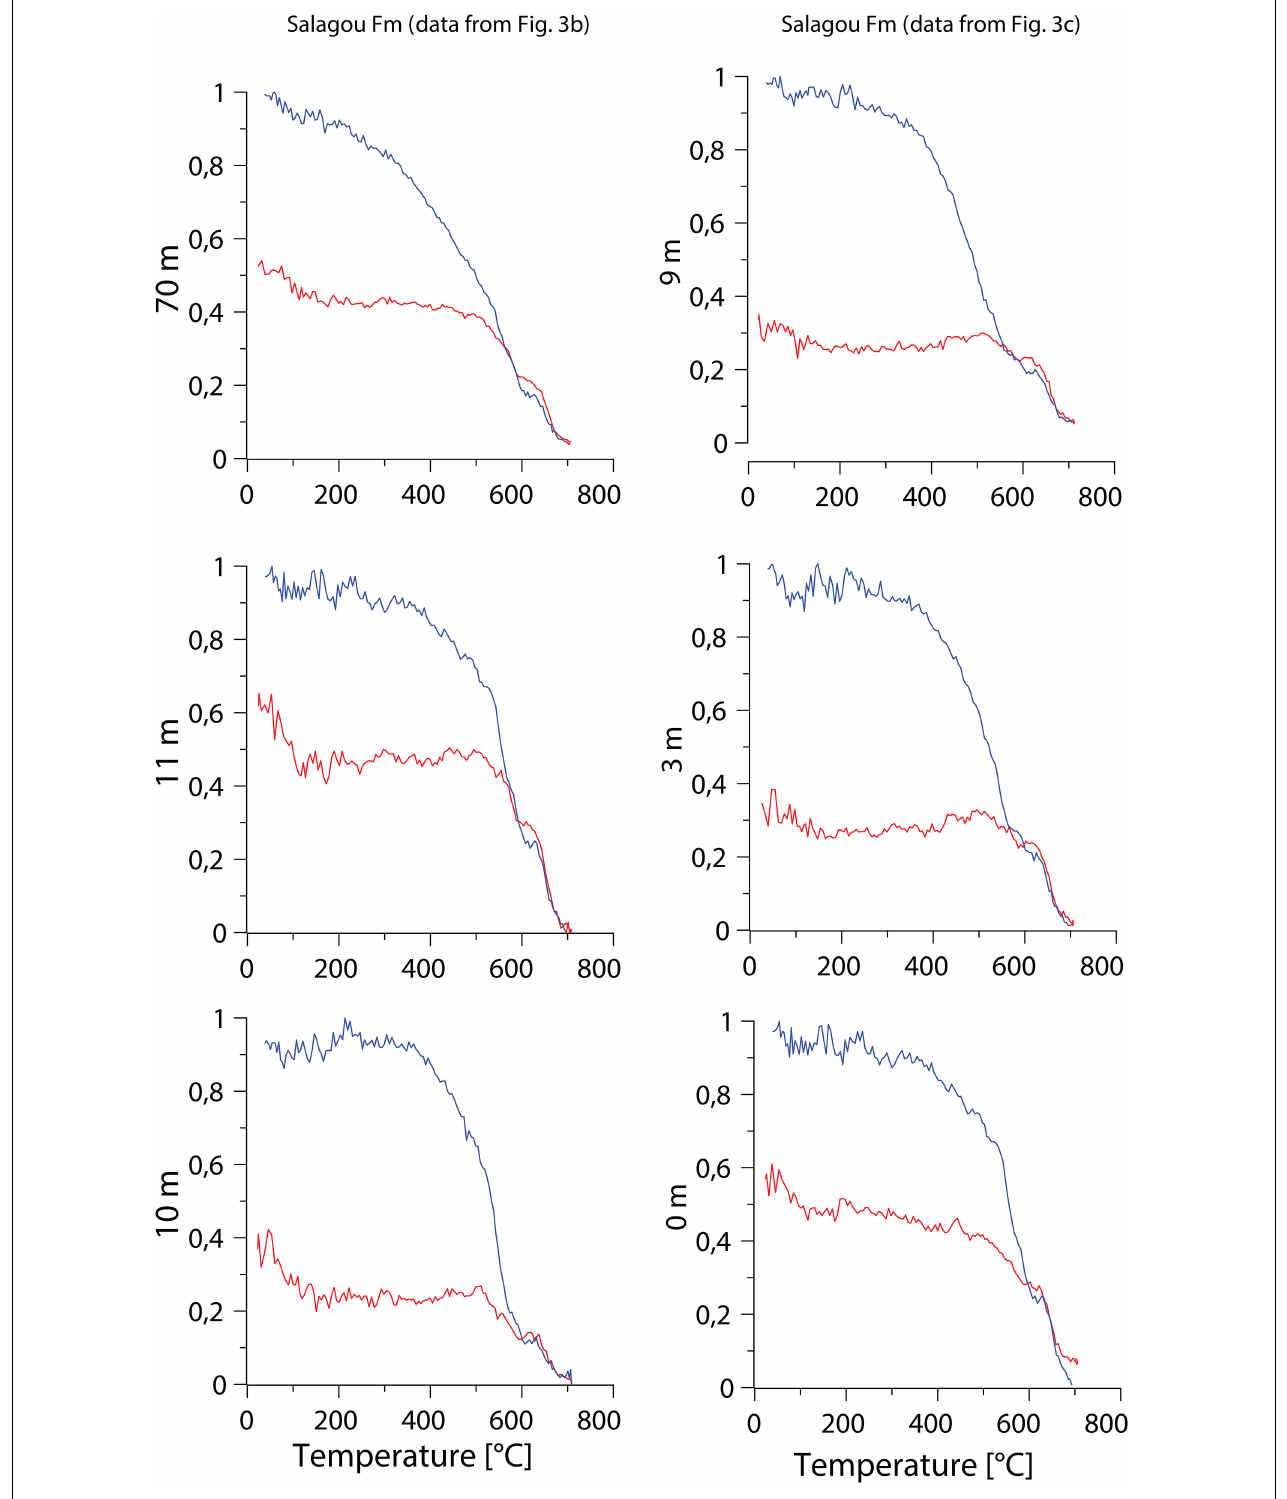
FIGURE 4 | Temperature-dependent susceptibilities of datasets for selected samples from discussed sections in Figures 3B,C . Heating (red) and cooling curves (blue) are plotted against χ lf, scaled to a maximum of 1 for comparison. Note that an χ lf decrease at the Curie temperature of magnetite (580 ◦ C) tends to be less expressed than the clear χ lf decrease at the Curie temperature of hematite (675 ◦ C).